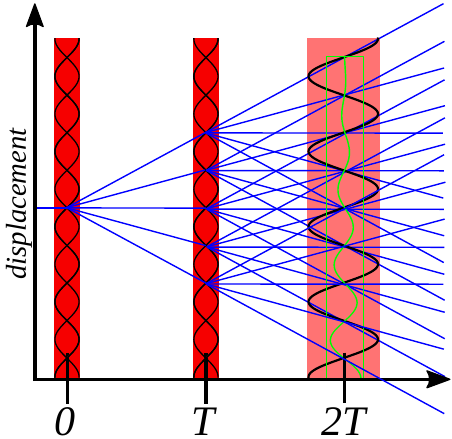
Figure 1. The schematic of a Talbot-Lau interferometer. An atomic cloud is split in space (vertical axis) by a laser pulse at time t = 0. The resulting diffracted orders separate, and are further diffracted at t = T . At the recombination time t = 2 T , the various orders overlap, allowing a probe laser to produce a back scattered signal from the periodic atomic distribution. We only show two diffraction orders because for typical laser pulses, higher orders are